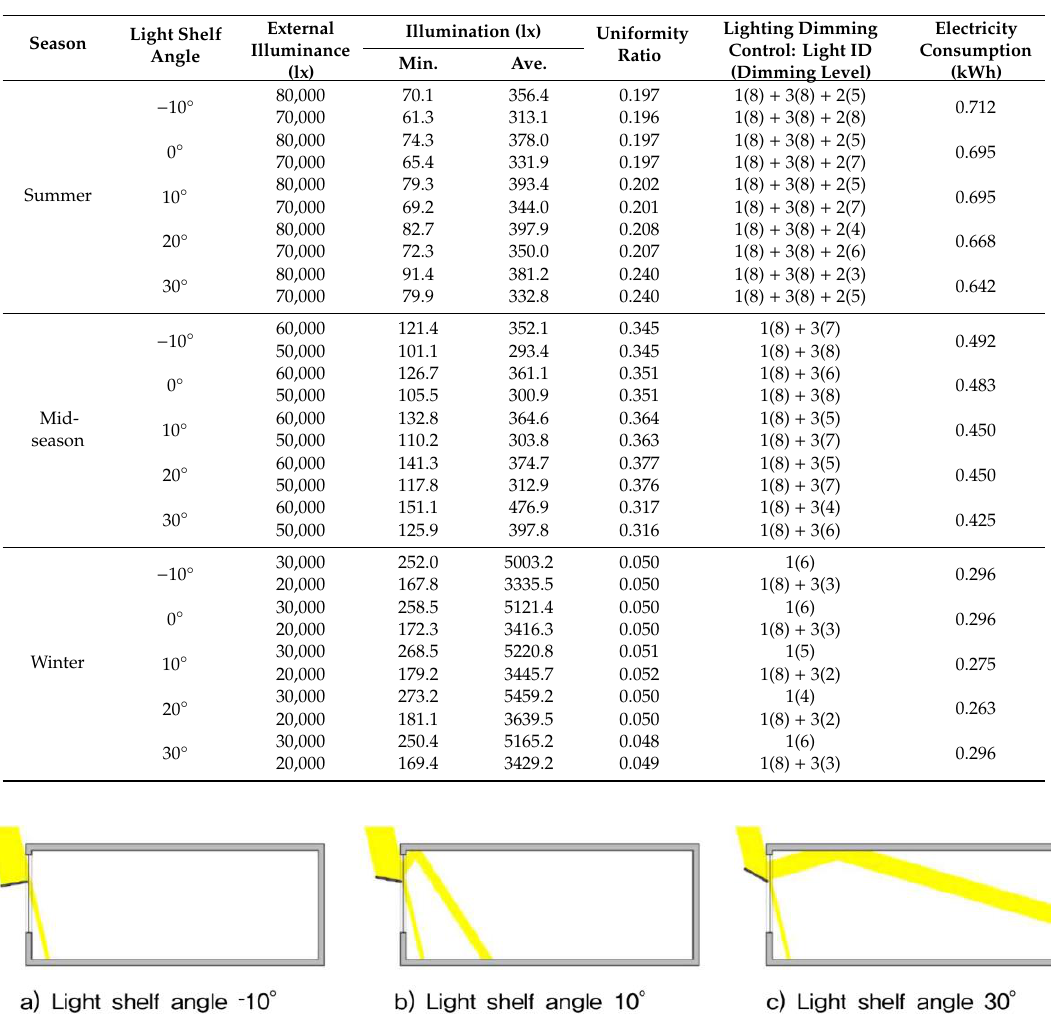
Figure 11. Inflow of natural light by the light shelf in summer depending on the angle.